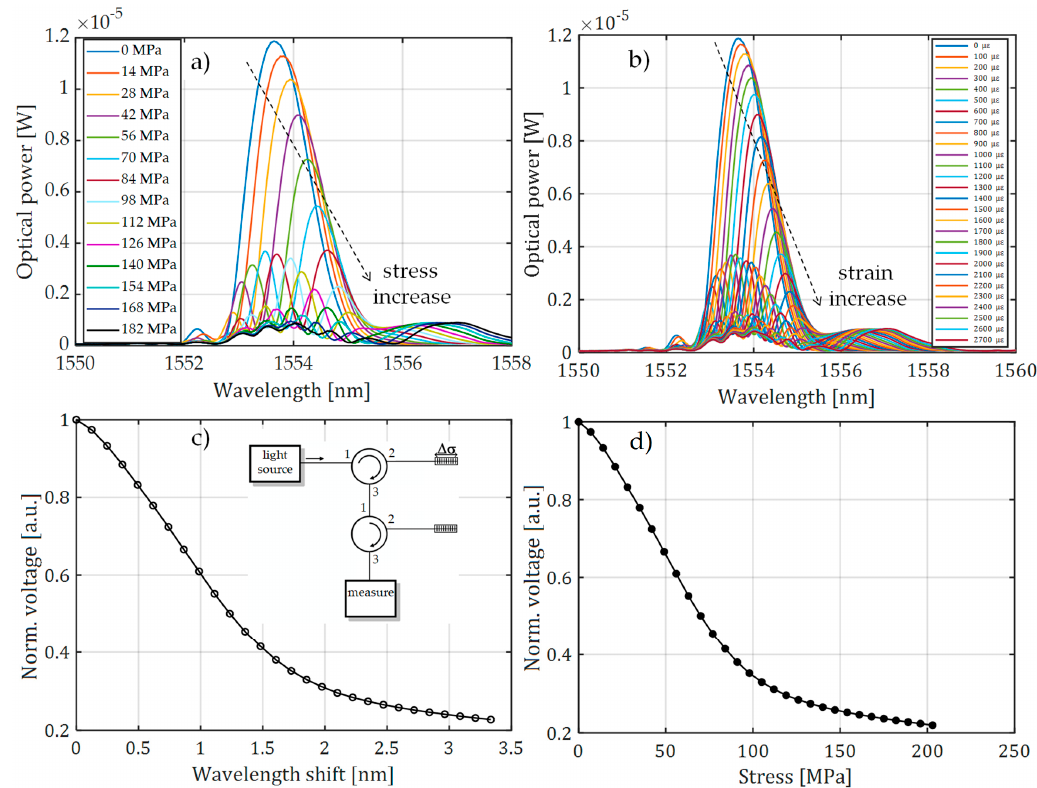
Figure 11. The measurement results obtained from the interrogation stand (as in Figure 9) for the matched grating pair FBG + FBG1: ( a ) spectral response change in response to an increase of tension; ( b ) spectral response change to an increase of strain; ( c ) the transient characteristic of wavelength shift to DC voltage generated by the photodetector; ( d ) characteristics of power line wire tension conversion to a change of photodetector voltage.